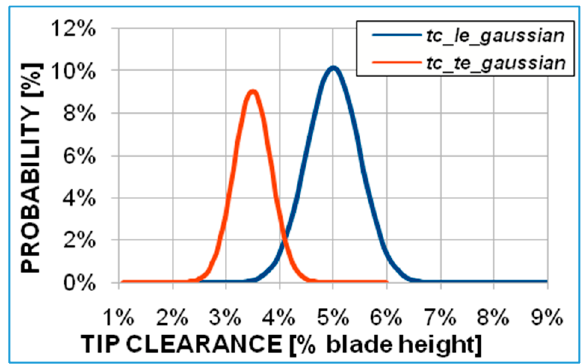
Table 2. Input uncertain variables range and statistics. TIP CLEARANCE